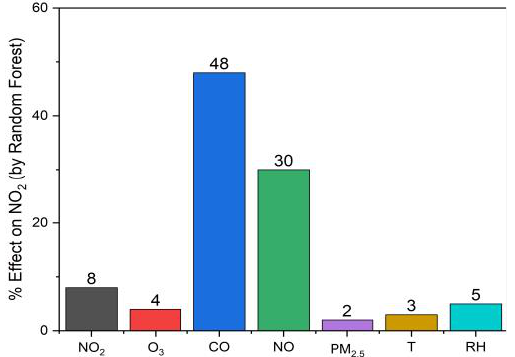
Figure 5. The importance of the ENSENSIA readings for correcting NO 2 using the RF algorithm. The importance is suggested by RF based on the training set (2021).